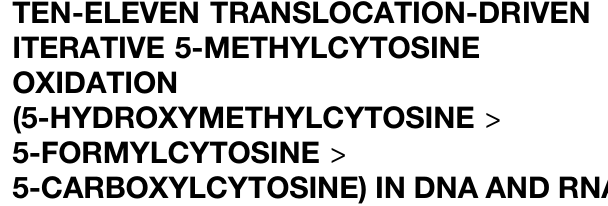
Frontiers in Cell and Developmental Biology |